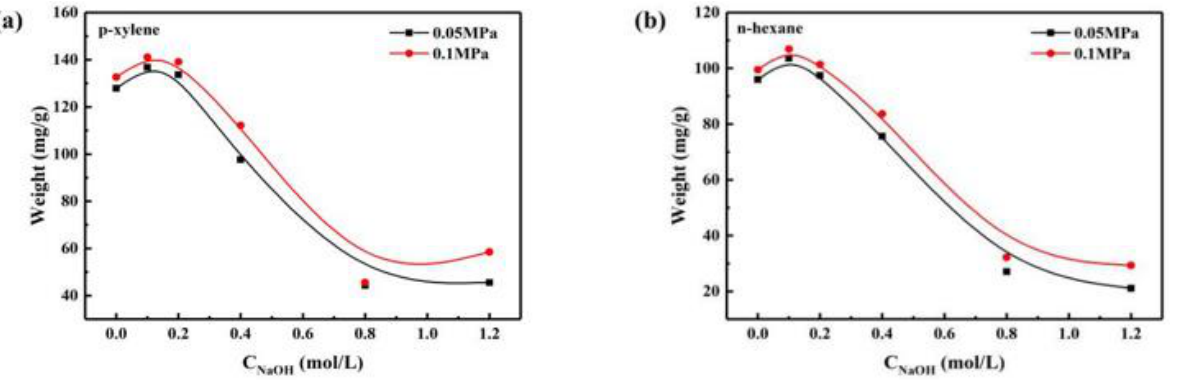
9 of 12 Figure 7. Relationship between sample adsorption capacity and pressure with respect to time before and after HCl and H 2 C 2 O 4 treatment. 2.9. Adsorption Performance of Waste Catalyst Subjected to Acid-Base Combined Treatment Figures 8 and 9 show that after treatment with 4 mol/L HCl and H 2 C 2 O 4 , the amount of p-xylene and n-hexane adsorbed by the waste catalyst after alkali treatment at different concentrations first increases and then decreases. When P/P 0 = 0.1 MPa, the H 2 C 2 O 4 con- centration is 4 mol/L and the NaOH concentration is 0.1 mol/l, the maximum adsorption capacity of the sample for p-xylene is 141.04 mg/g, and the maximum adsorption capacity